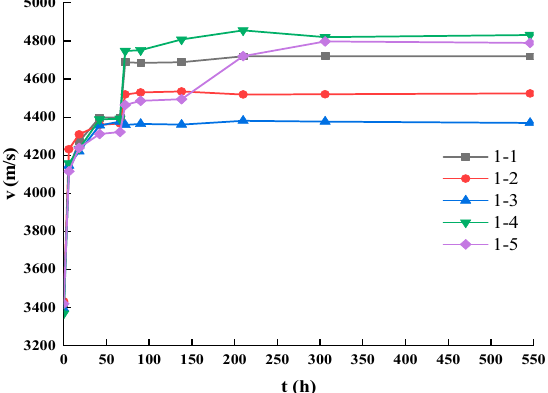
Figure 2. Diagram of sample water absorption changing with immersion time.